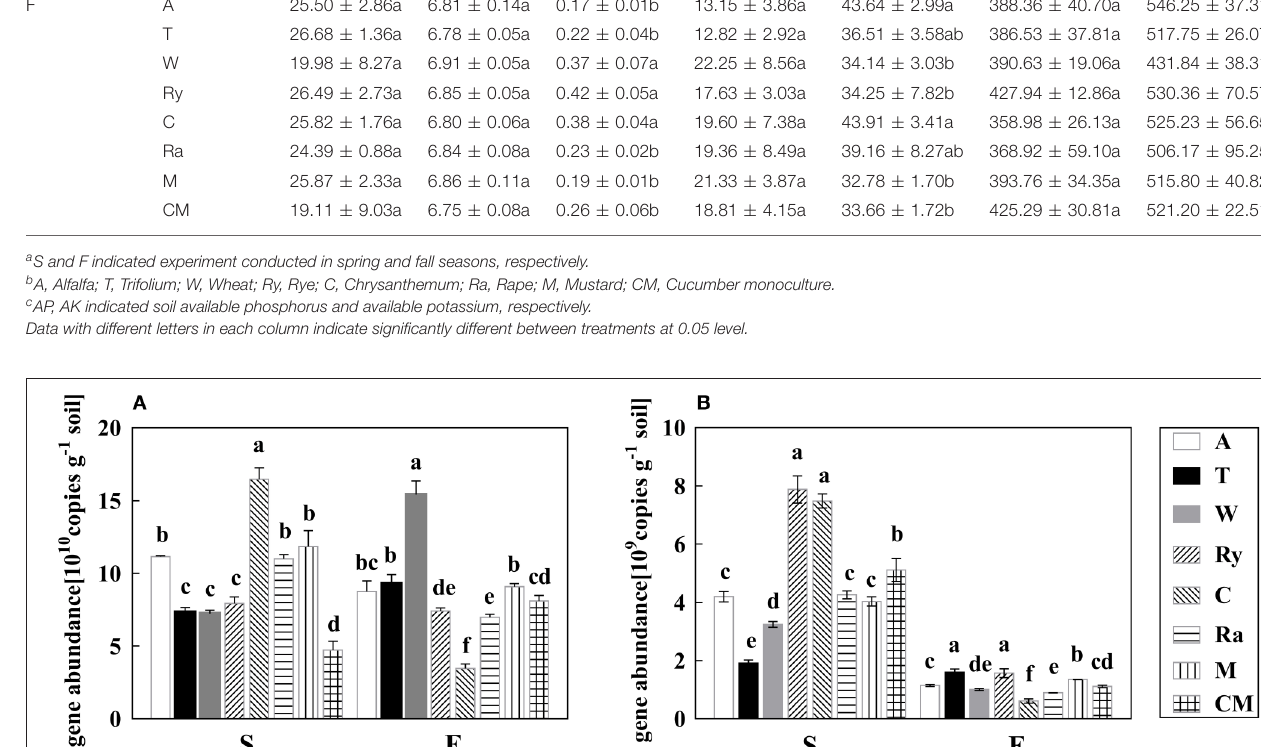
bacterial abundance in the fall ( P < 0.05), and the